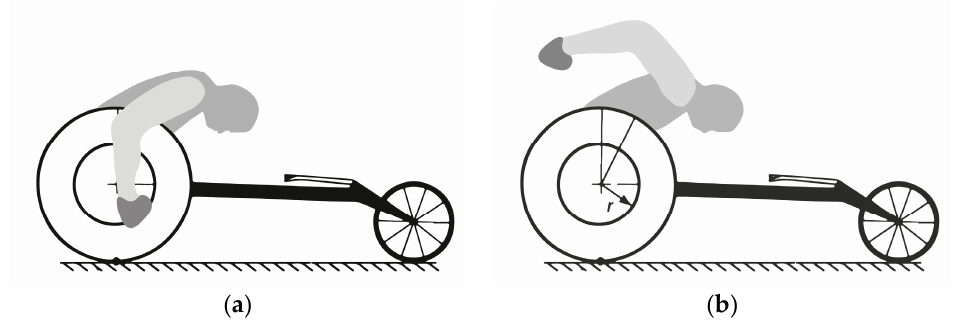
Figure 5. Typical range for a full push cycle (adapted from [7]): ( a ) arms pushing the rim with glove at the lower edge of the rim; ( b ) arms extended with glove raised to some extent above the